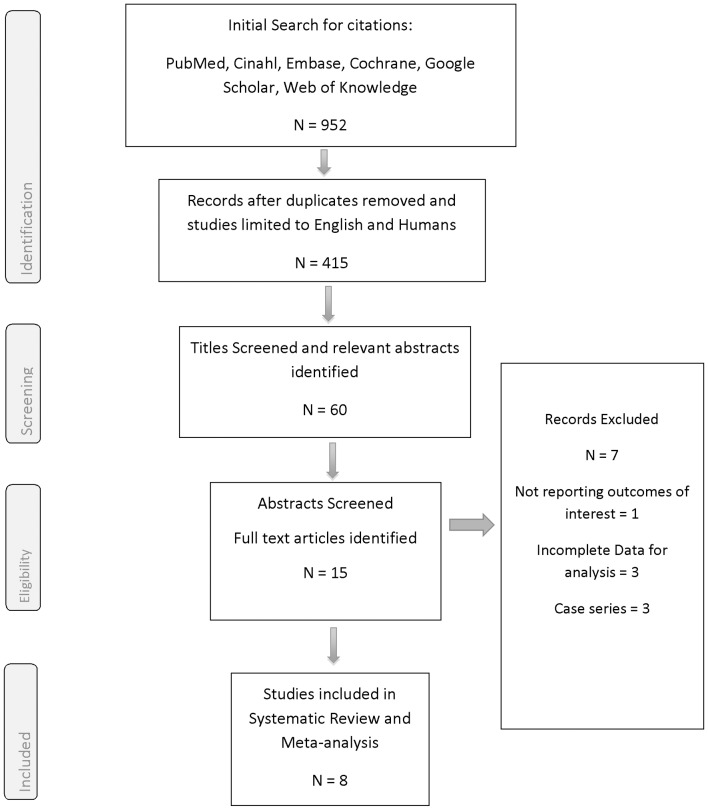
Prisma Flow Diagram.